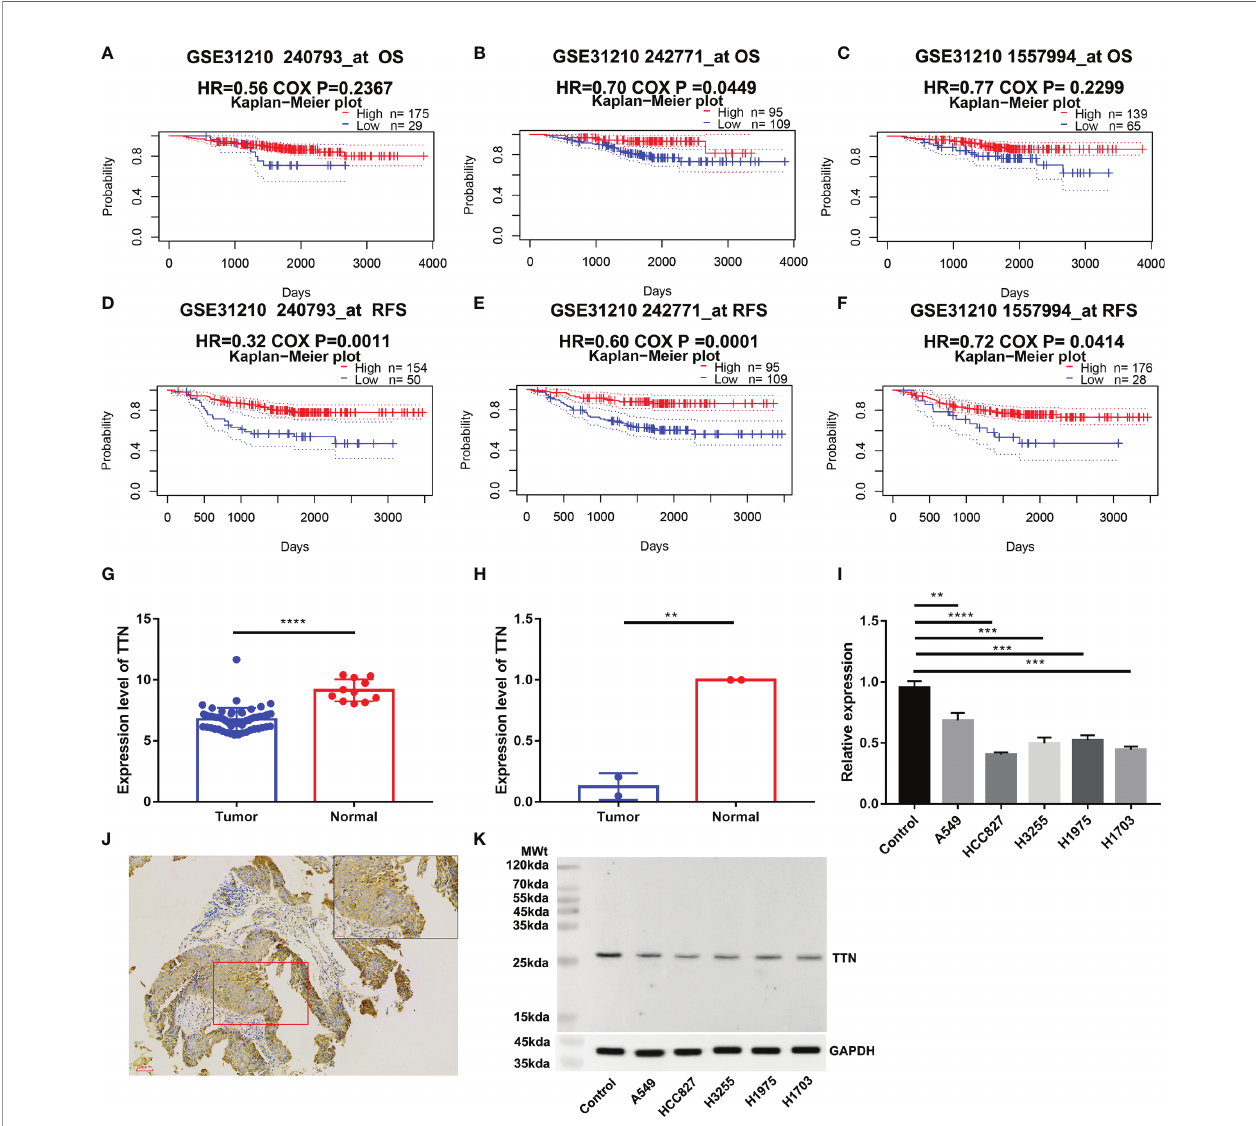
FIGURE 8 | Validation of TTN expression and prognostic value. OS and RFS of LUAD patients in the cohort (GSE312100, n=204) (A – F) ; Expression of TTN in cohort (GSE116959, n= 68) (G) ; TTN expression level in 2 LUAD tissue samples and 2 paired normal tissue samples (H) ; TTN expression level in 4 LUAD cell samples,1 LUSC cell sample and 1 normal alveolar epithelial cell sample (I) ; Immunohistochemical analysis of the expression of titin in LUAD (J) . Western blotting analysis of expression of titin in 5 different lung cancer cell lines and human pulmonary alveolar epithelial cells (K) . (* P < 0.05, ** P < 0.01, *** P < 0.001, **** P <